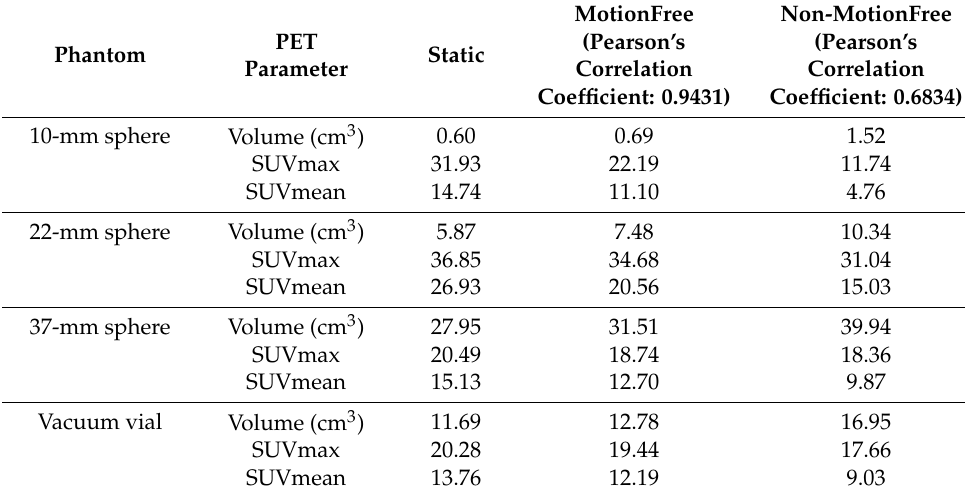
Table 3. The results of the phantom study.